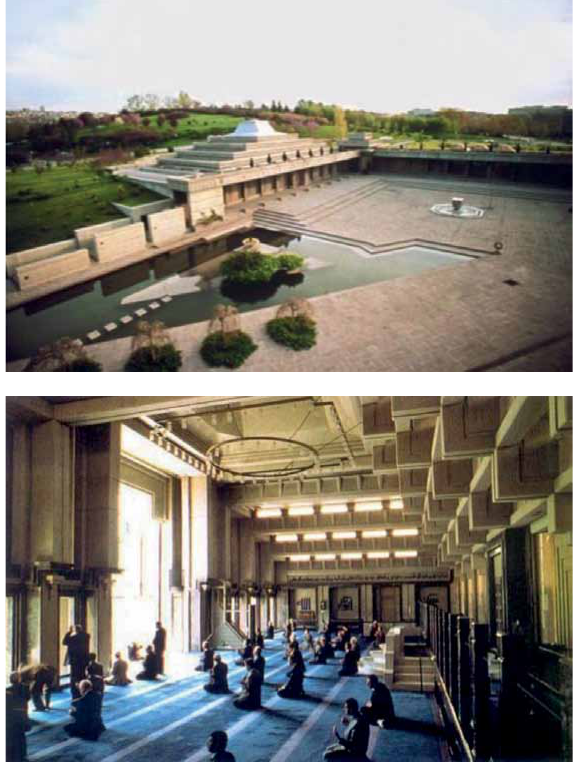
fig. 9. G.n.a.T Mosque, ankara. Source: v3.arkitera.com